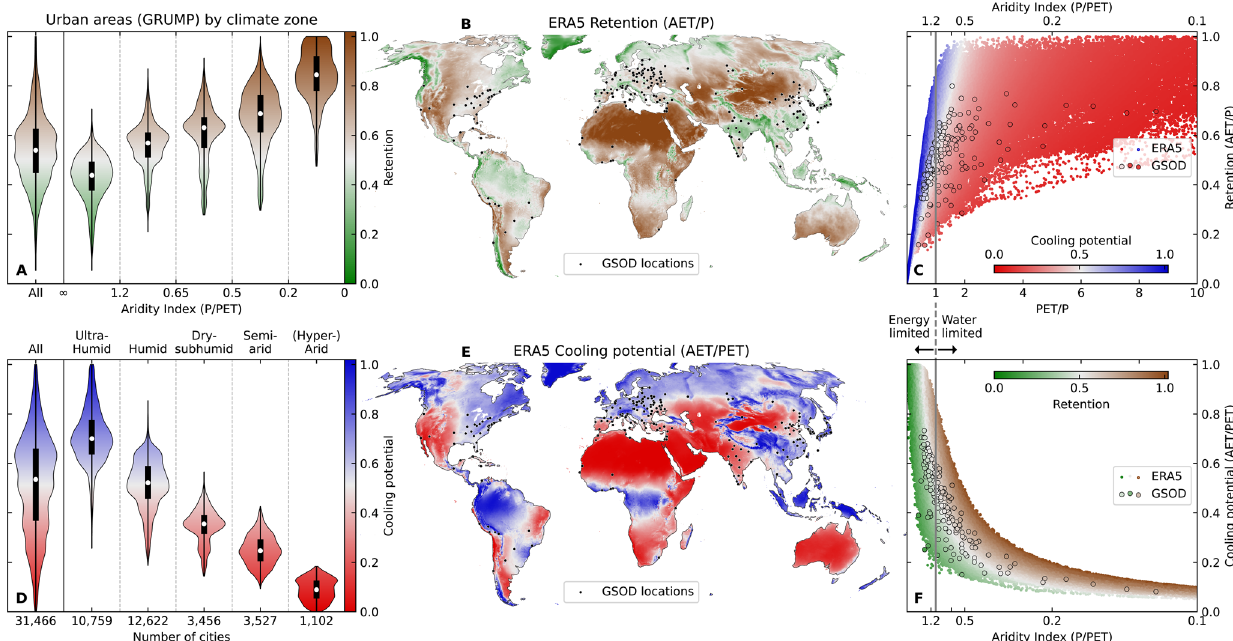
Fig. 1 Global patterns of urban greening hydrological retention and cooling potential. Spatial distributions and interrelationships of ERA5 re-analysis data forced models using intensive substrate ( h = 150 mm) for: ( B, C ) Retention and ( E, F ) Cooling potential. ( A, D ) Violin plots for data extracted from GRUMP 18 urban areas only. GSOD 19 city point-data and locations are shown for reference in ( B, C ) and ( E, F ). Equivalent results for other substrates are given in Supplementary Figs. 6 and